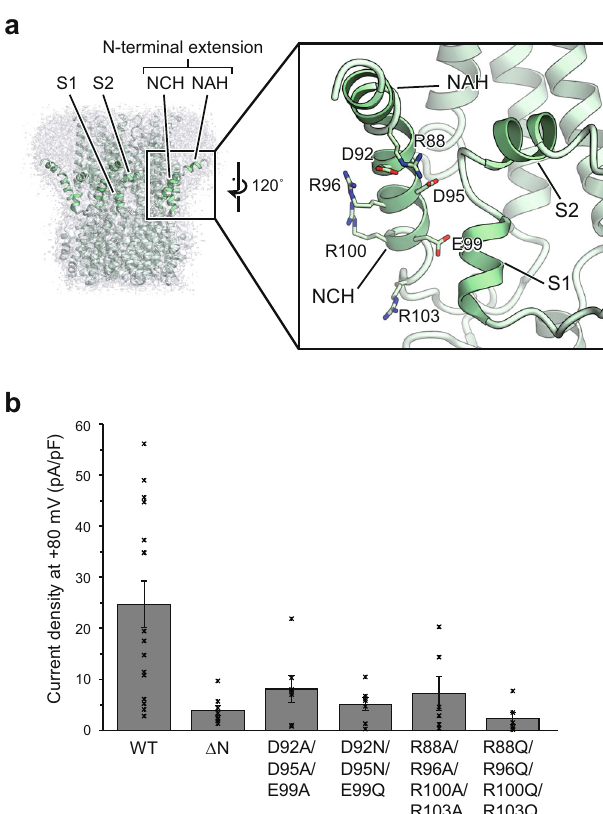
Fig. 6 N-terminal extension of MdVCCN1. a Overview and close-up view of the NTD of MdVCCN1. The gray density in the overview represents the cryo-EM map including the lipid nanodiscs. b Whole-cell current density at + 80 mV in HEK293 cells expressing the MdVCCN1 wild-type, N-terminal truncated mutant and NCH mutant (wild-type ( n = 16), Δ N ( n = 8), D92A/ D95A/E99A ( n = 7), D92N/D95N/E99Q ( n = 7), R88A/R96A/R100A/ R103A ( n = 7), R88Q/R96Q/R100Q/R103Q ( n = 6)). Error bars represent s.e.m. Source data are provided as a Source Data fi